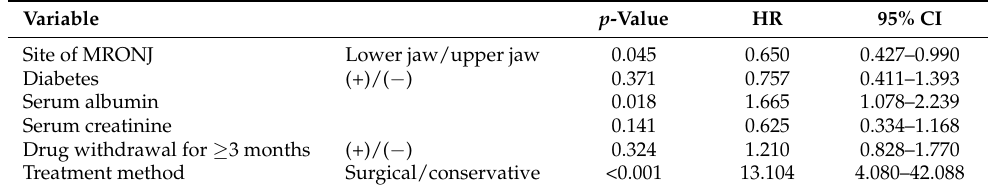
Table 3. Factors related to healing rate of MRONJ by multivariate analysis (Total: 166 patients). Variable